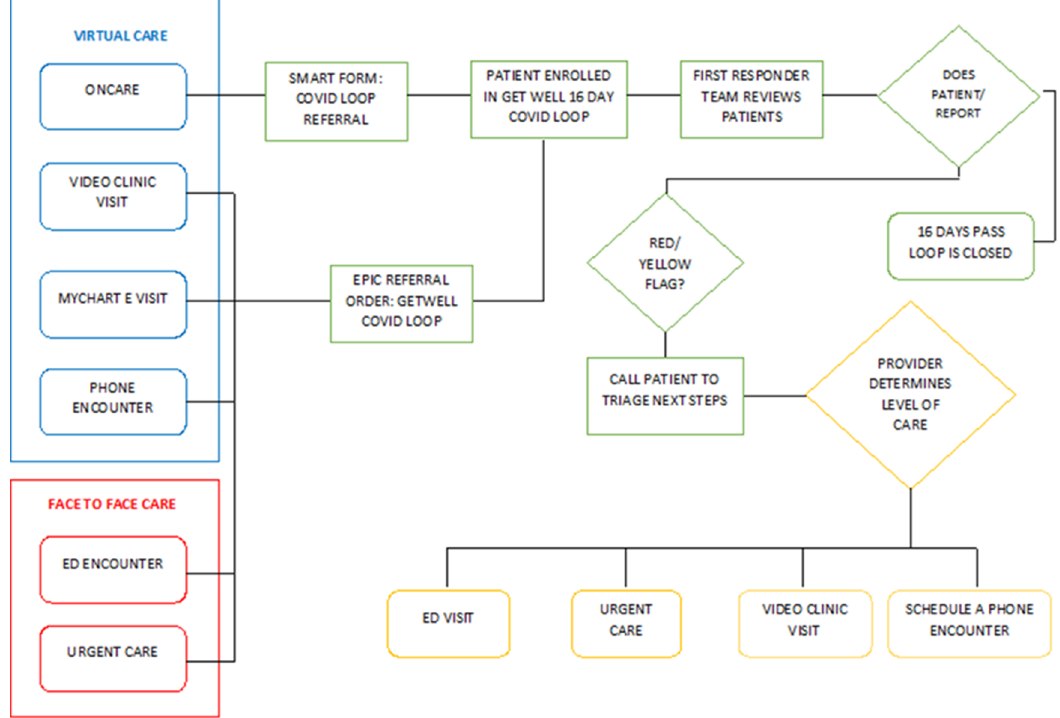
Figure 1. COVID-19 remote patient monitoring program overview